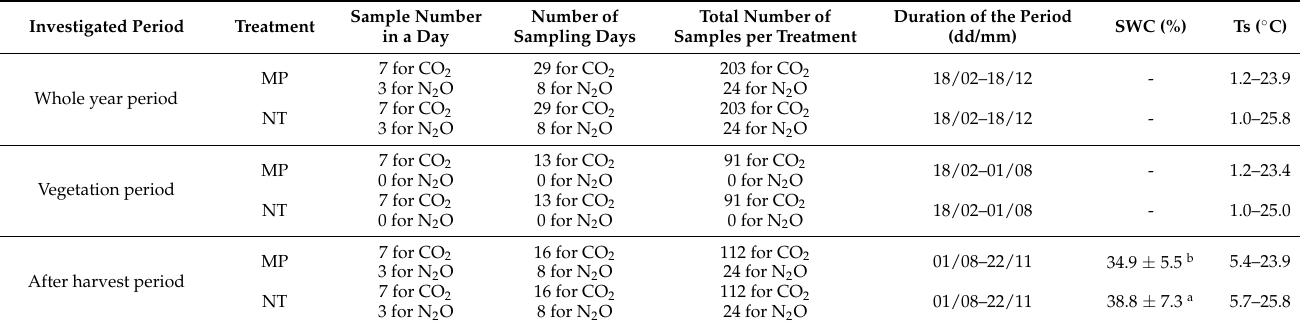
Table 4. Sampling strategy and basic environmental parameters of the field experiment with small letters indicating significant differences between soil water content (SWC) of the treatments. Tillage treatments: MP: mouldboard ploughing, NT: no-tillage. Ts—soil